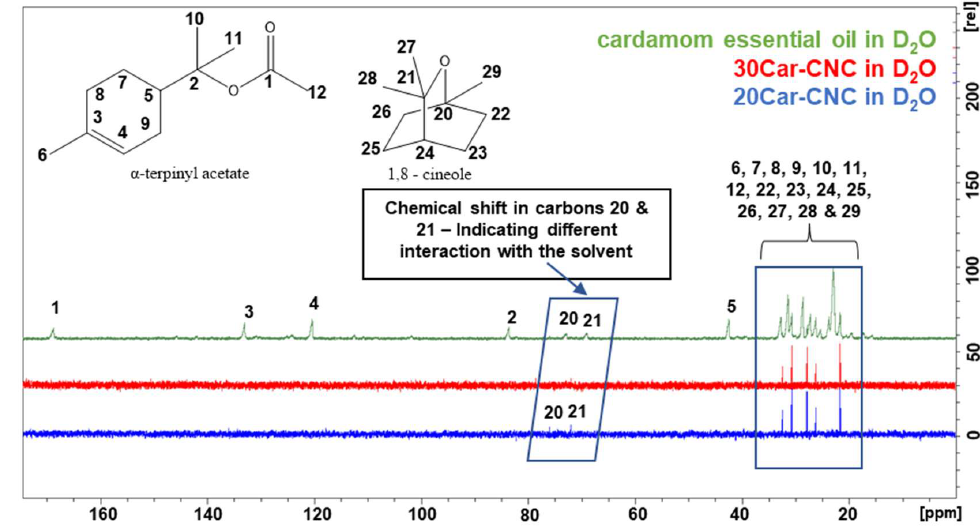
Figure 7. 13 C spectra of EO Cardamom essential oil ( Elettaria cardamomum , CAS Number 8000-66-6), 30Car–CNC and 20Car–CNC emulsions diluted with D 2 O.